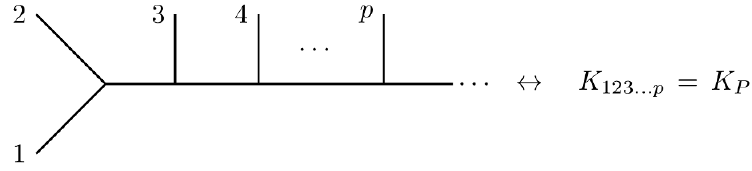
Figure 2 . The correspondence between local multiparticle superfields K